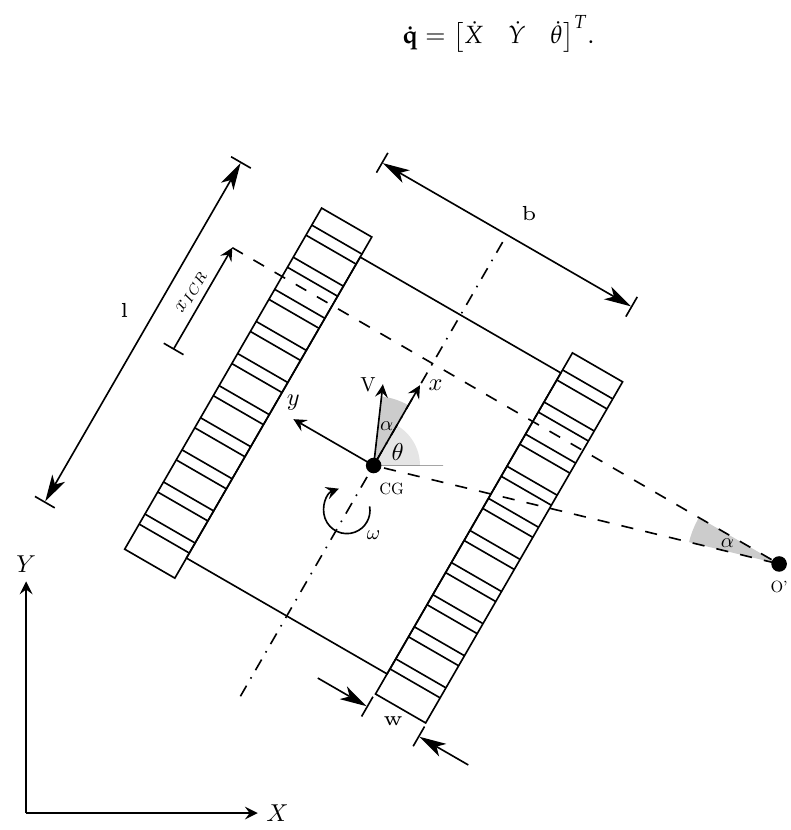
Figure 3. Kinematics of a tracked